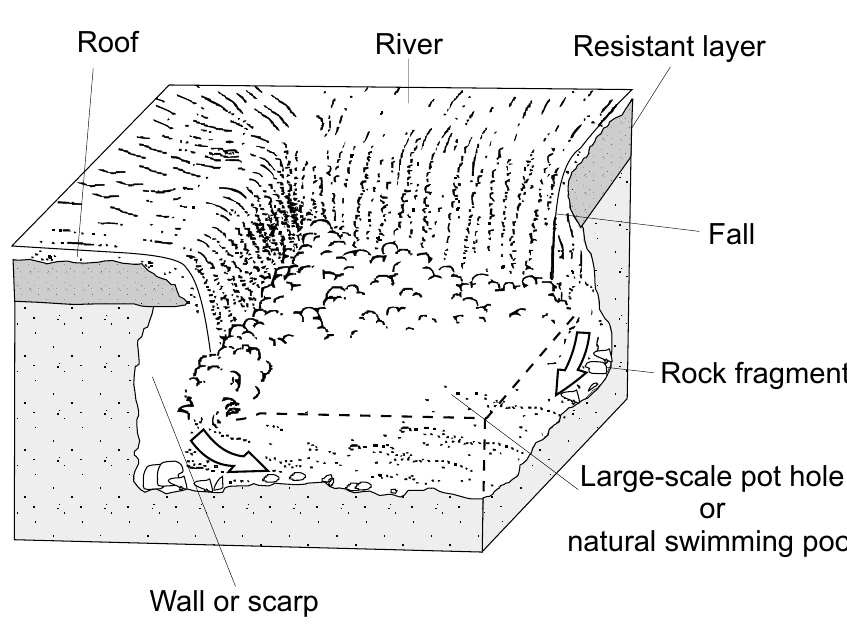
Fig. 5 – Morphological elements of waterfalls (after Coltrinari